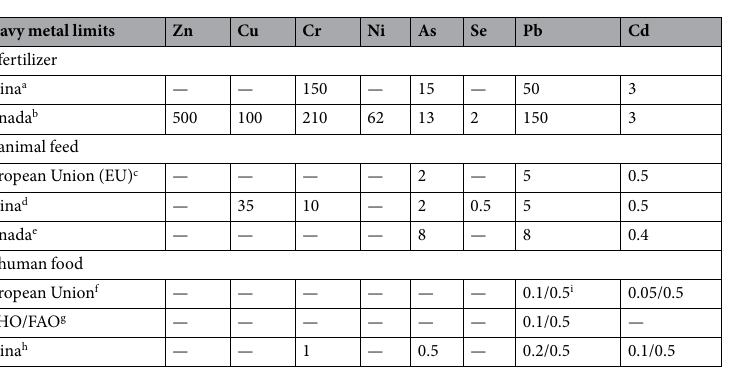
Table 2. Heavy metal limits in fertilizer, animal feed and human food (mg/kg). ‘—’ means the standard of relevant heavy metal concentration have not been stipulated. a Source: Standard for microbial organic fertilizers, NY 884–2012, China, 2012. b Source: Compost quality standards, Brinton W, 2000. c Source: EU standards for arsenic, cadmium, lead, nitrites, volatile mustard oil and harmful botanical impurities, No 1275/2013, EU, 2013. d Source: Standard for feeds, GB 13078–2001, 2001 and standard for copper as well as selenium (GB 26418– 2010) in feeds, 2011. e Source: Standard for feeds, Canadian Food Inspection Agency, 2015. f Source: Standard for foodstuffs (No 1881/2006 and No 629/2008), EU. g Source: Standard for contaminants and toxins in the GSCTFF, FAO/WHO, 2011. h Source: Standard for contaminants in foodstuffs (GB 2762–2012), 2012. i Heavy metal limit in